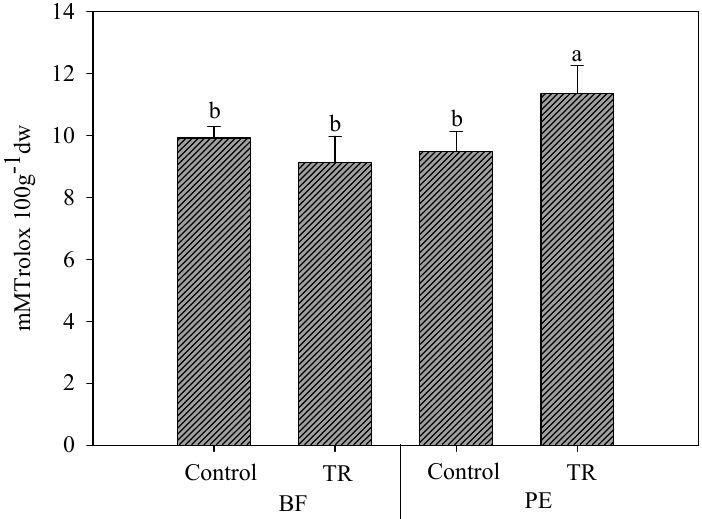
Figure 2. Effect of mulching films (brown photoselective film—BF and black polyethylene—PE) and Trichoderma application (untreated—Control and treated—TR) on lipophilic (LAA) antioxidant activity of lettuce leaves. All data are expressed as mean; n = 3.